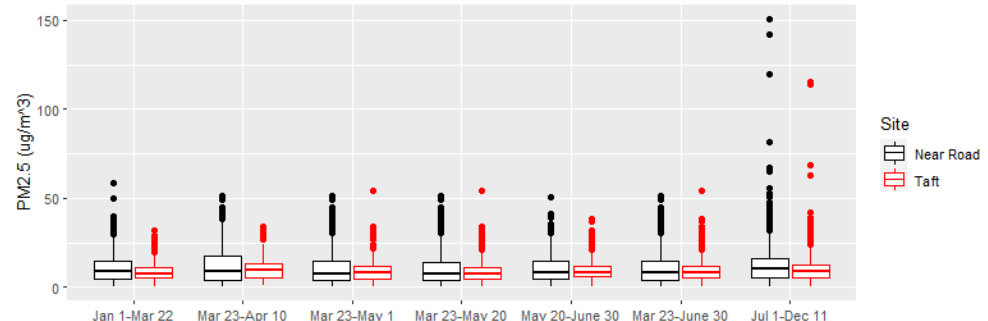
Figure 8. Boxplots of hourly PM 2.5 during each time period of interest during 2020 at the Near Road and Taft and Taft sites.